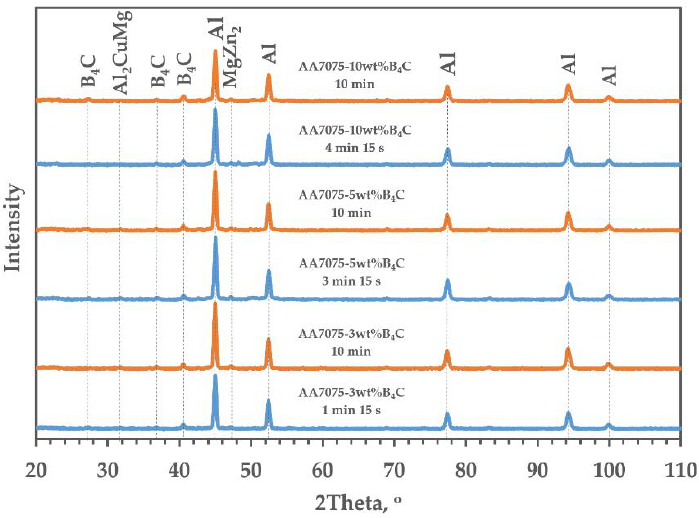
Figure 6. X-ray diffraction spectra of AA7075- x B 4 C ( x = 3, 5, 10 wt%) depending on SPS parameters.